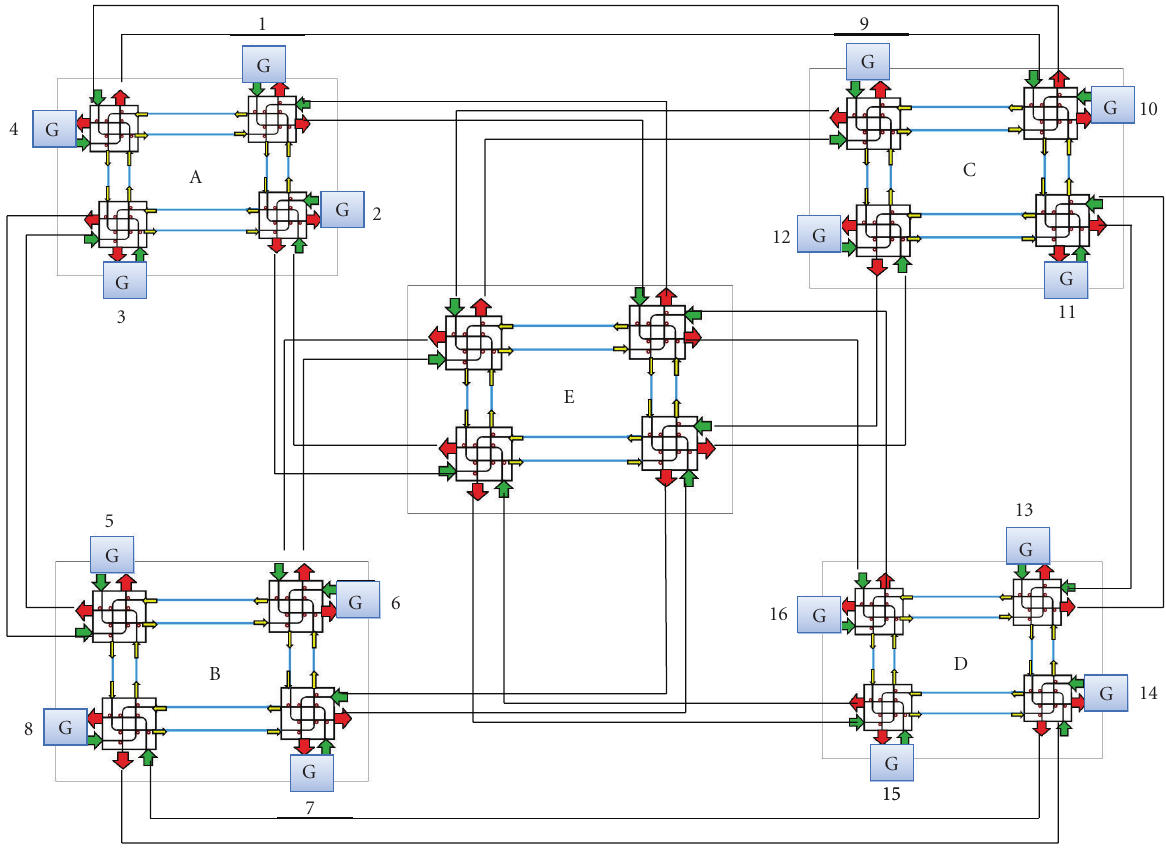
Figure 8: 4 × 4 square root topology.